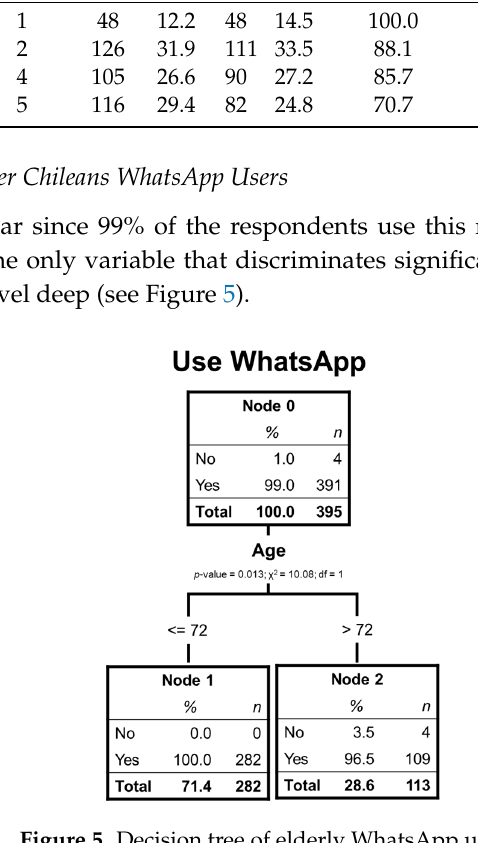
Table 13. Estimation risk for using WhatsApp (CHAID method).